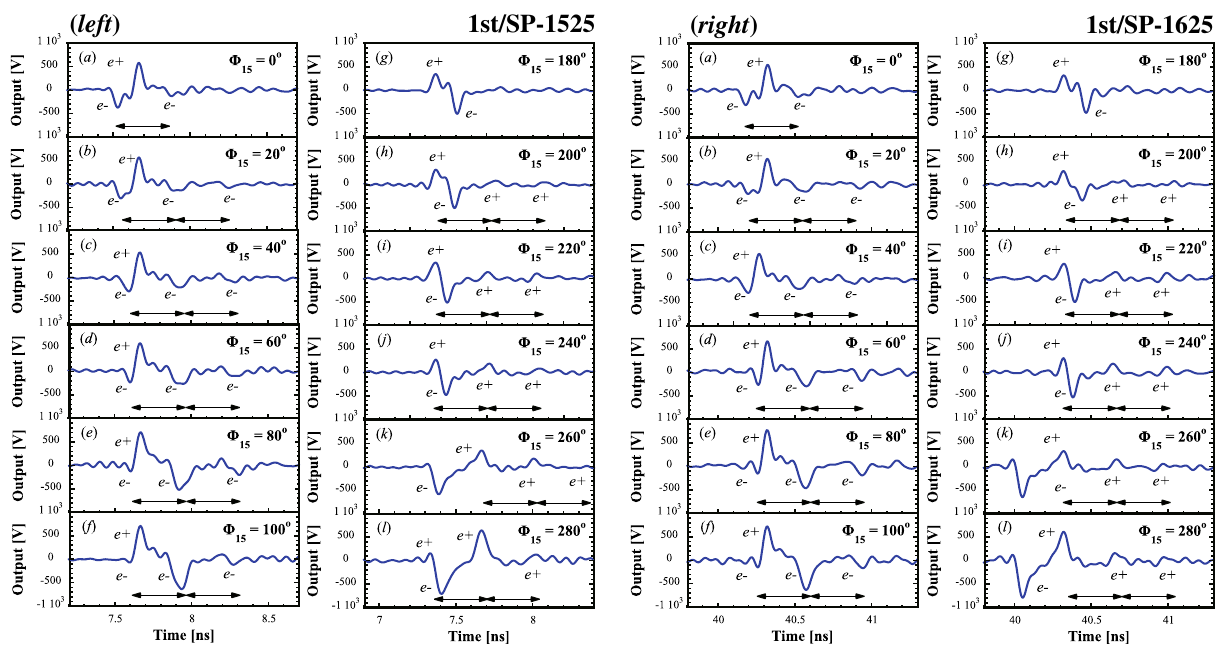
Figure 2. ( left ) Variations in the sum signal waveforms of WBM as a function of the capture phase (cid:31) 15 for the first bunch of SP15-25 ( (cid:31) 15 = 0 o − 100 o ( a – f ) and (cid:31) 15 = 180 o − 280 o ( g – l ). ( right ) Variations in the sum signal waveforms of WBM as a function of the capture phase (cid:31) 15 for the first bunch of SP16-25 ( (cid:31) 15 = 0 o − 100 o ( a – f ) and (cid:31) 15 = 180 o − 280 o ( g – l ). The solid line arrows indicate a time scale of 350 possible. The sum signal is obtained from the signal sum after the peak positions of four channels for the e − bunch are made to coincide with each other in time. Note that it was verified that the time intervals (cid:31) t analyzed in Fig. 1b–d were consistent with each other within measurement errors. The result shows that the corrected signals are properly corrected for any transient responses up to the cutoff frequency, because any signal waveform distortion is suitably eliminated except for the baseline noise due to the significant wakefields. The oscilloscope can automatically correct the signals in the frequency domain and display them pulse-by-pulse in real time and in the time domain without any difficulty. Direct observation of the dynamical phase‑slip process. Figure 2 shows the variation in the bunch configuration with time for the first bunch of ( left ) SP15-25 and ( right ) SP16-25 as a function of the capture phase (cid:31) 15 of AC15 with a step phase of 10 o , for which the phase (cid:31) 16 of AC16 was concurrently changed by the same step phase. Here, note that the phases (cid:31) 15 = 0 o and (cid:31) 16 = 0 o are defined under the nominal operation condition. It can be seen that at the nominal phase (cid:31) 15 = 0 o , the e − bunch precedes the e + bunch in time sequence (see Fig. 2a). It is also found that a small amount of e − charges starts to be delayed from the e − main bunch, and e − satellite bunches are formed with a ∼ 350 ps delay from the main bunch. Here, a time scale of 350 ps indi- cated by a solid line arrow corresponds to one rf cycle of the fundamental accelerating frequency (2856 MHz), as shown in Fig. 2b. Note that the solid line arrows are drawn only in case that the satellite bunches are clearly identified. It is interesting that with increasing (cid:31) 15 , the pulse areas of the e − satellite bunches increase along with that of the e + main bunch, whereas the pulse area of the e − main bunch decreases, as shown in Fig. 2c–f (called phase-slip process, see Methods for details). These results clearly show that the charges of both the main and satellite bunches vary in the phase-slip process since the bunch charge is proportional to the pulse area. At (cid:31) 15 = 40 o , the pulse areas of the e − main and first satellite bunches are almost balanced, and the relationship between them is finally reversed at (cid:31) 15 = 60 o . It can also be seen that the pulse widths of the e − main and satel- lite bunches vary as a function of the capture phase because the bunch length is defined as the pulse width. The results indicate that such behaviors of the bunches in the time sequence and the variations in the longitudinal asymmetric bunch shapes except for the nominal phase (cid:31) 15 = 0 o are still in the transient region in terms of the phase-slip process. The phase (cid:31) 15 = 40 o may be close to an intersection in time in terms of the interchange of the e − and e + main bunches. Here, note that only two e − satellite bunches can be detected with difficulty because the baseline fluctuation level due to wakefields limits their detection. On the other hand, at (cid:31) 15 = 180 o , the e + bunch precedes the e − bunch (see Fig. 2g). Figure 2g–l show the variations in the phase-slip process of the bunches in the phase regions between (cid:31) 15 = 180 o and (cid:31) 15 = 280 o , which are 180 o apart from the previous (cid:31) 15 setting (� 15 = 0 o − 100 o ) . The results show that similar phase-slip processes can be found in which the entire reverse behaviors in the time sequence are generated when the e − and